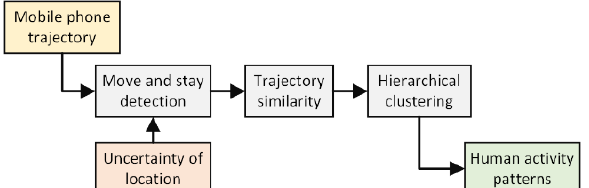
Figure 1. The workflow to clustering mobile phone positioning